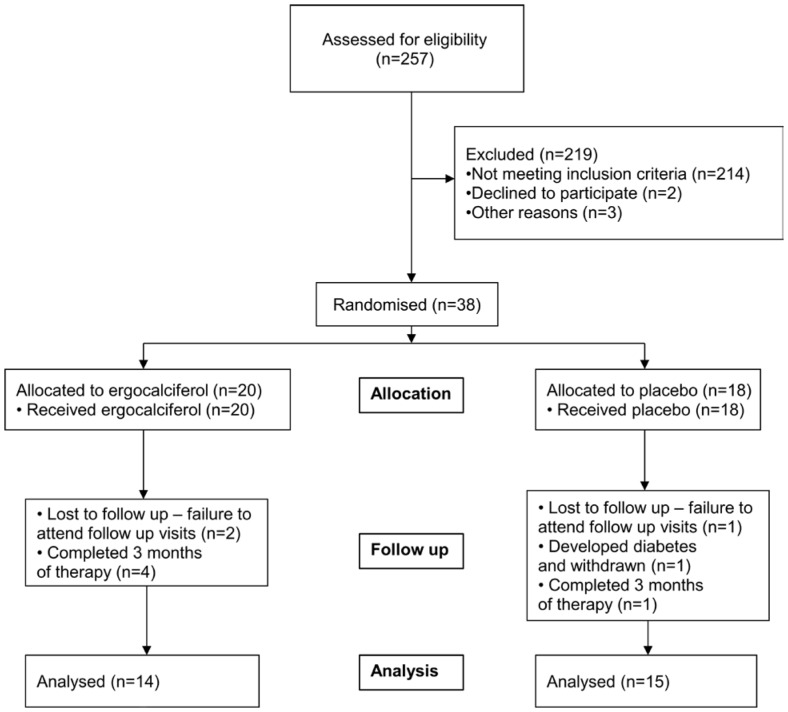
Recruitment schedule for study patients.